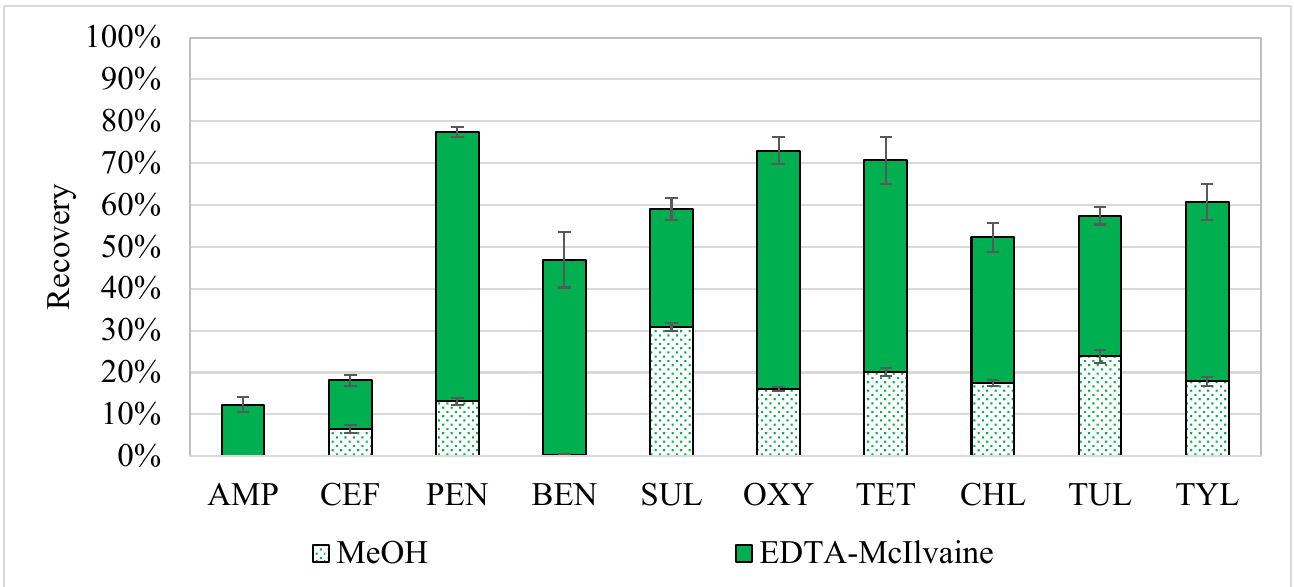
Figure 2. Recoveries from the initial two-step extraction experiment with EDTA-McIlvaine (solid bar) as the first extractant followed by MeOH (dotted bar) as the second extractant. Resulting recoveries were averages (n = 3), with error bars based on ± standard error. The antibiotics examined included Ampicillin (AMP), Ceftiofur (CEF), Penicillin-G (PEN), Benzylpenicilloic Acid (BEN), Sulfadimethoxine (SUL), Oxytetracycline (OXY), Tetracycline (TET), Chlortetracycline (CHL), Tulathromycin-A (TUL), and Tylosin Tartrate (TYL).